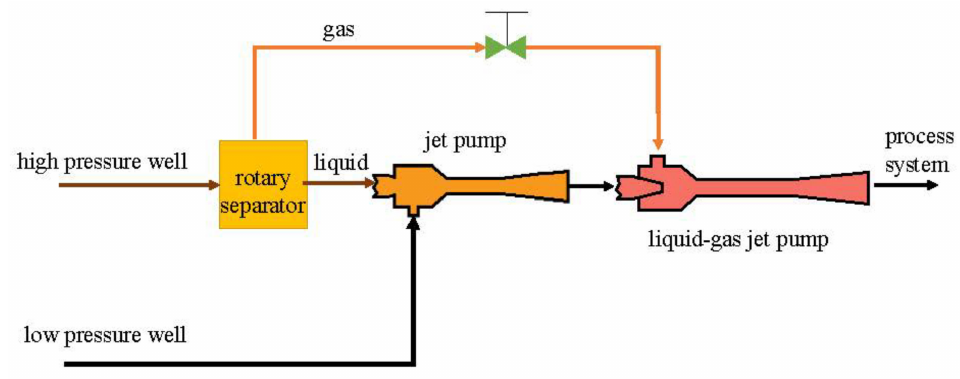
Figure 4. Schematic diagram of Wellcom